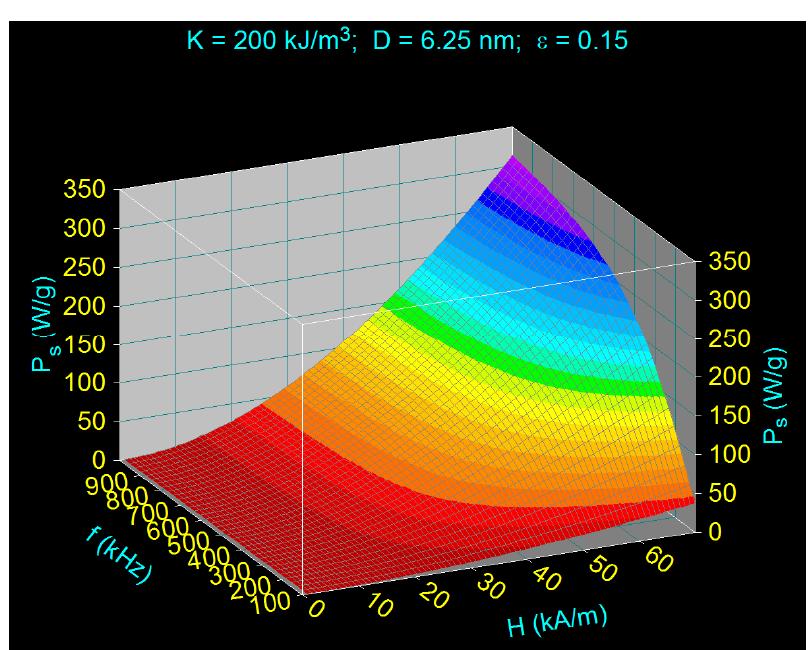
Figure 3. The variation of specific loss power (P s ) as a function of the amplitude (H) and frequency (f) of magnetic field for the diameter (D) of the CoFe 2 O 4 nanoparticles of 6.25 nm. (iv)